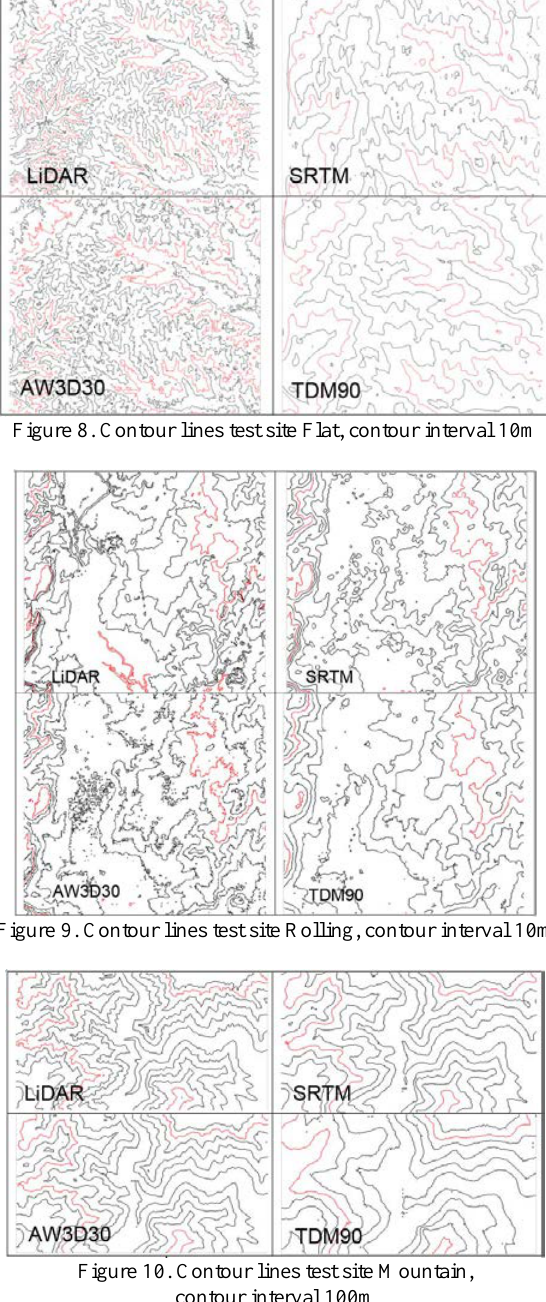
Figure 10. Contour lines test site Mountain, contour interval